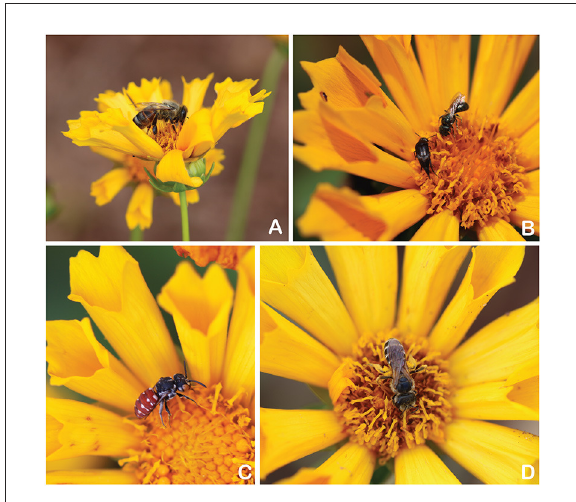
FIGURE3 Flower visitors observed on aster: (A) Melissodes sp., (B) Svastra sp., and (C) Syrphidae, (D) Syrphidae.